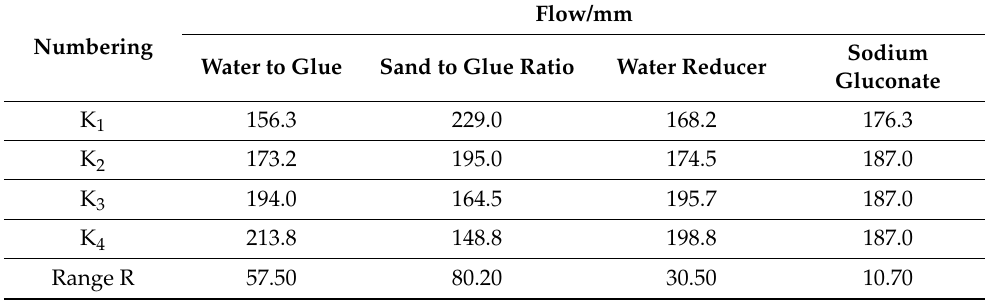
Table 8. Influence of various factors on flow.